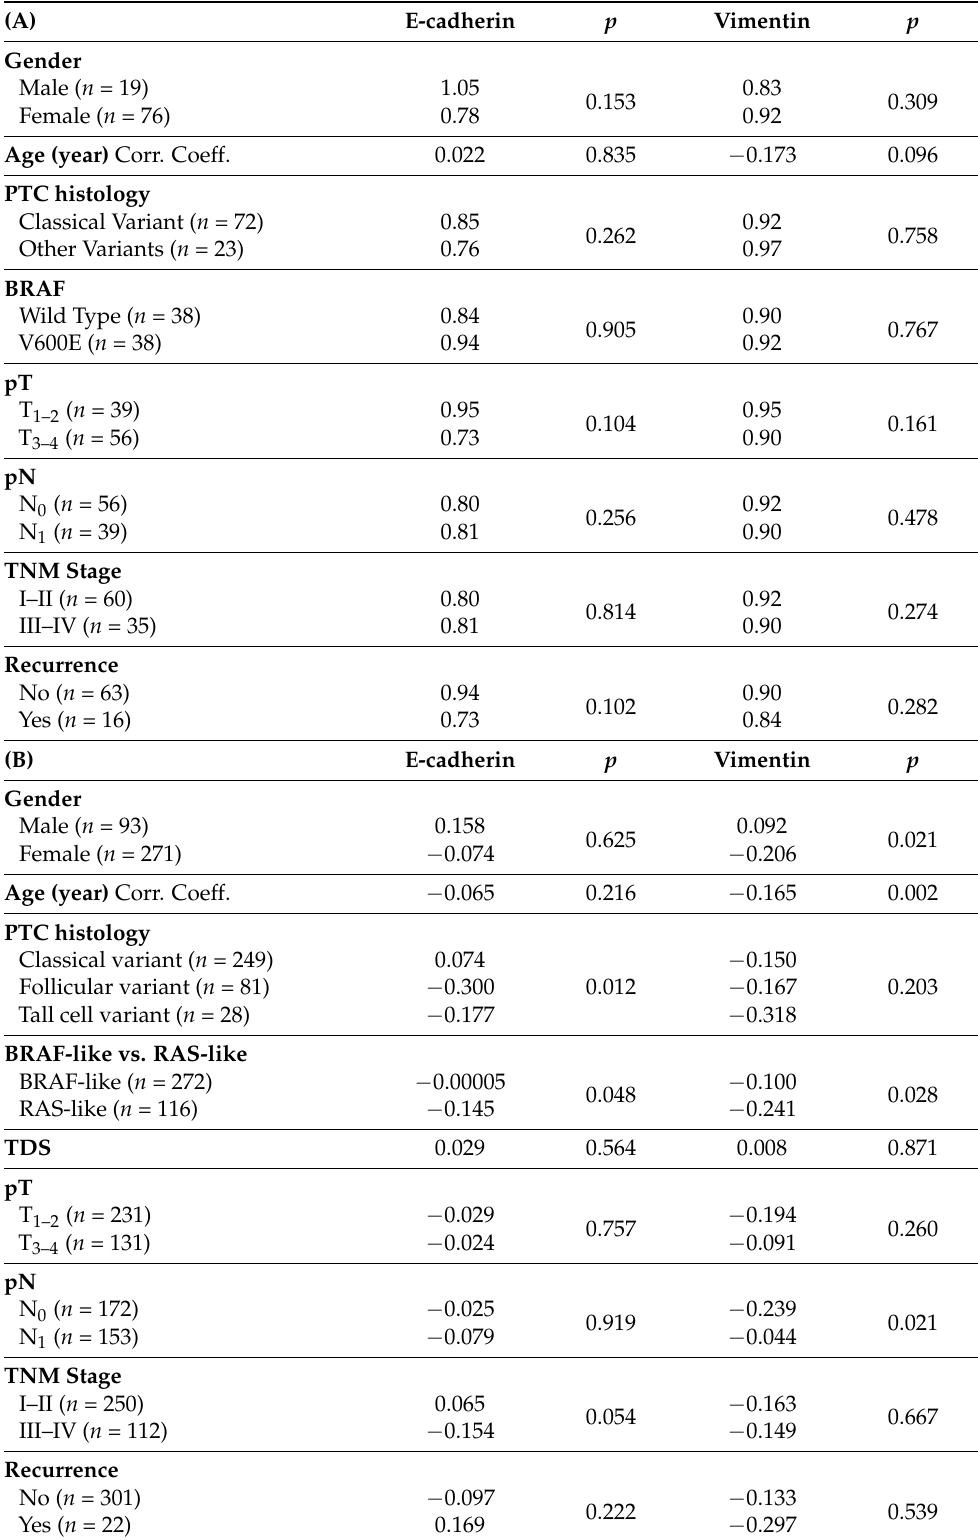
Table 5. A univariate analysis of the E-cadherin and vimentin expressions and clinicopathological fea- tures of PTC patients from the present case study ( A ) or from the TGCA database ( B ). In parentheses is the number of patients. TDS, Thyroid Differentiation